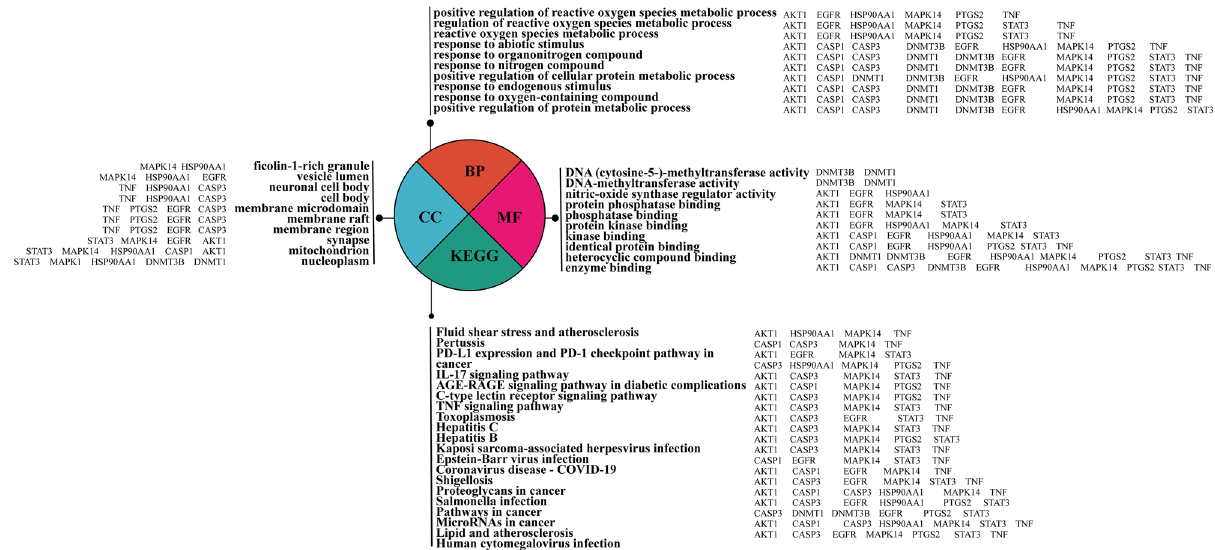
Figure 8. Of relationship between Hub gene and GO and